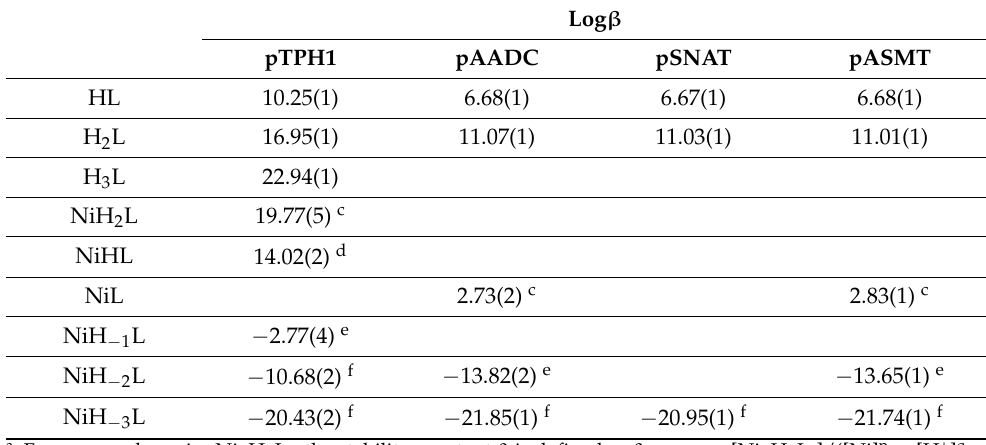
Figure 5. Speciation of Ni(II) complexes with peptides pTPH1 ( A ), pAADC ( B ), pSNAT ( C ), and pASMT ( D ). The common left axis shows Ni(II) complexes molar fractions. Common right axes show either absorbance at a maximum of the d-d band or ellipticity at the extrema of respective d-d bands. Shown are Ni(II) aqua ions (orange dashed line), 1N (N Im ; red), 2N (N Im , N Im ; yellow), 3N (N amide , N amide , N Im ; green), 4N (N amide , N amide , N amide , N Im ; dark blue and light blue), and a sum of 3N and 4N (black dotted line) complexes. Presented are overlayed values of absorbance (full gray sym- bols) and CD (empty gray symbols) values.